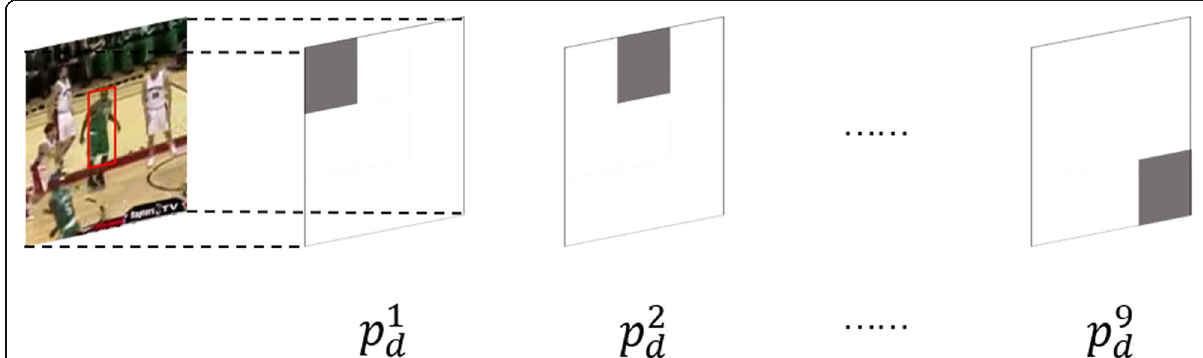
Fig. 2 Binary masks. When considering two-dimensional case and suppose m = 9, the binary masks from p 1 d , p 2 d , … , p 9 d are shown in the figure where the gray pixels are assigned the value of 1 and the white pixels are assigned the value of